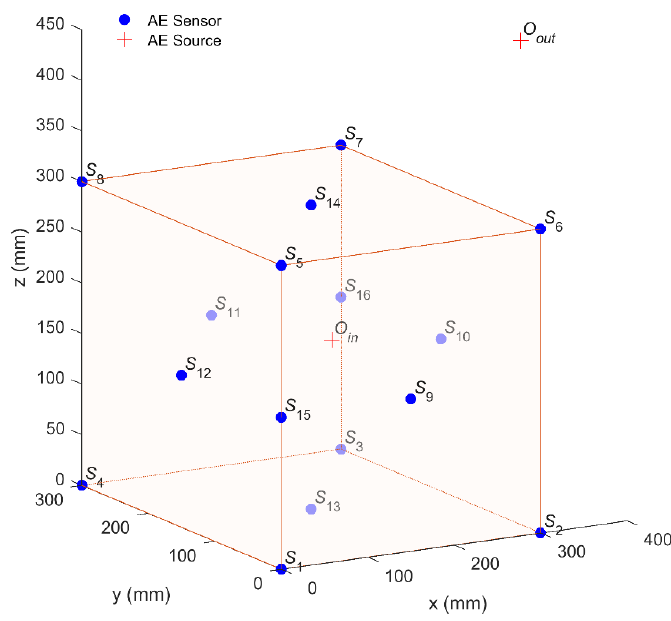
Table 3. The coordinates of 16 AE sensors in the simulation test. Sensor No.